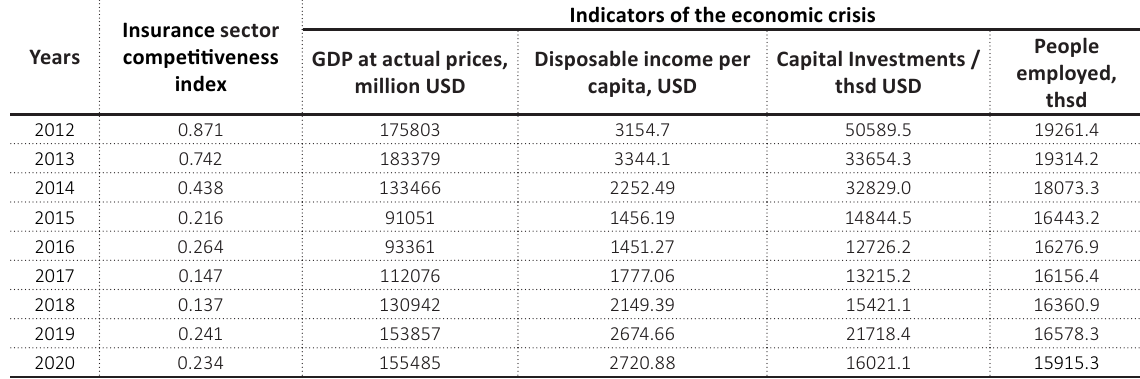
Table 3. Integral index and factors of competitiveness of the insurance sector in Ukraine